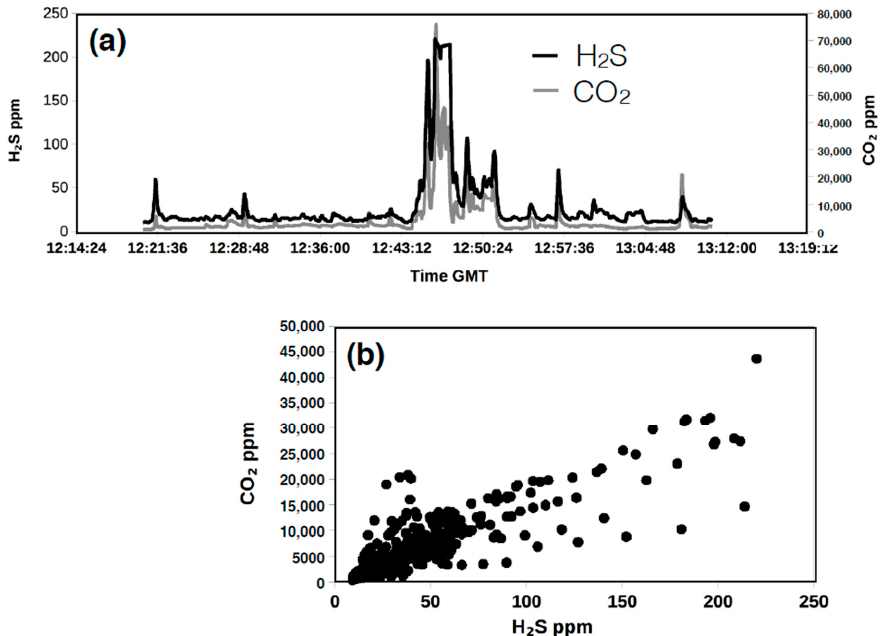
Figure 3. ( a ) temporal variations of CO 2 and H 2 S concentrations for 1512 point measurements 2–20 cm above the Fangaia mud pool (green and grey dots in Figure 4), ( b ) CO 2 versus H 2 S concentrations using RatioCalc software (https://sites.google.com/site/giancarlotamburello/home ) [29].